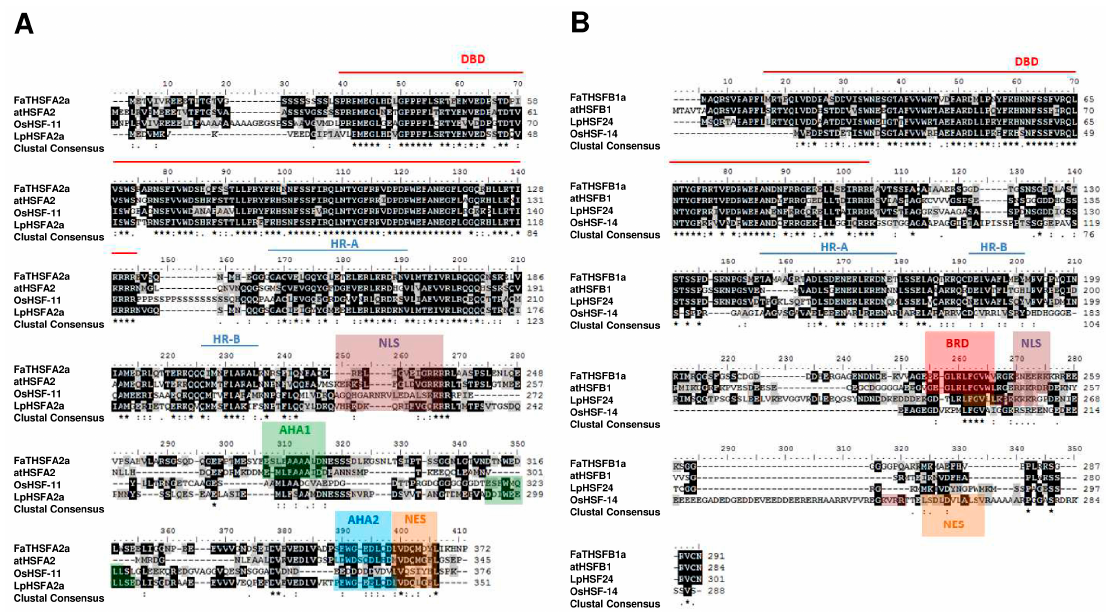
Figure 3. Sequence comparisons of FaTHSFA2a, FaTHSFB1a, and the related HSF proteins. ( A ) Amino acid sequence alignment of the full-length FaTHSFA2a and related HSF proteins, including atHSFA2 (At2g26150, A. thaliana ), OsHSF-11 (AAQ23058, O. sativa ), and LpHSFA2a (CAA47870, L. peruvianum ); ( B ) Amino acid sequence alignment of the full-length FaTHSFB1a and its associated HSF proteins, such as atHSFB1 (At4g36990, A. thaliana ), OsHSF-14 (AAQ23055, O. sativa ), and LpHSF24 (P22335, L. peruvianum ). This sequence alignment was performed by ClustalX 1.8 and BioEdit 7.0 software. Completely and partly conserved amino acids in proteins are shaded in black and gray, respectively. The letters and marks in the alignment are represented as follows: DBD (red line), HR-A and -B (blue line), NLS (highlighted in brown), AHA (highlighted in light green for AHA1 and light blue for AHA2), NES (highlighted in orange), and BRD (highlighted in red).